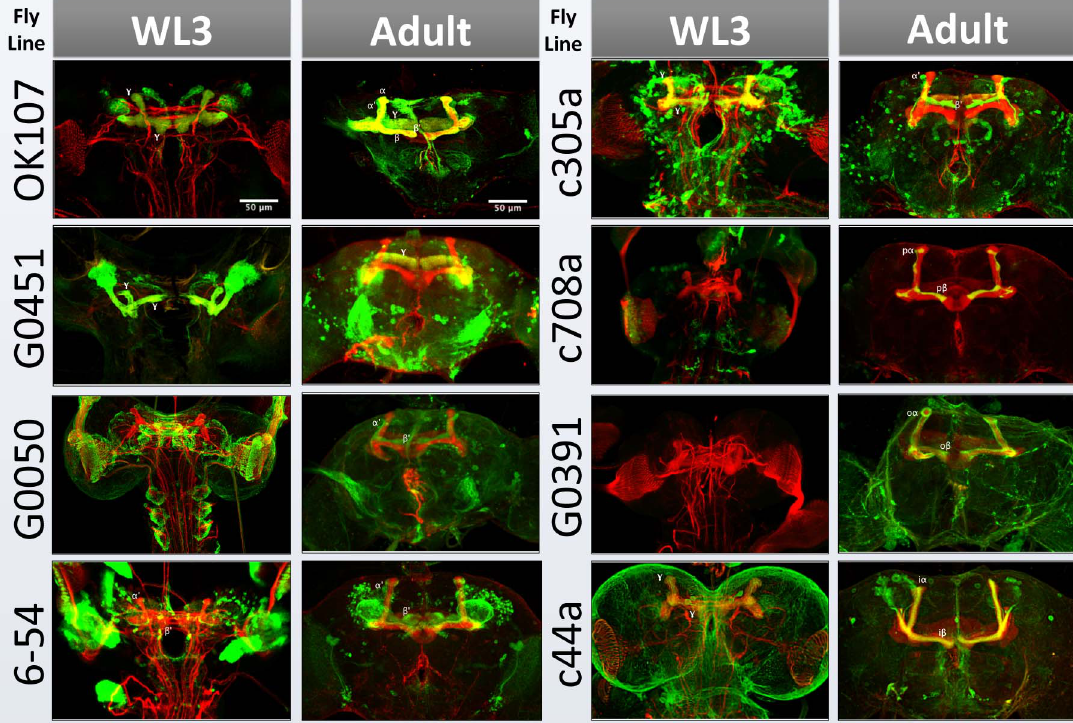
Fig. 5. Expression patterns of GAL4 enhancer trap lines in the fly brain. Each GAL4 strain was used to drive a UAS-CD8-GFP reporter gene (green) and brains were dissected at the wandering third instar larval stage (WL3) and adult. All samples were counterstained with an antibody to FasII (red) to label the developing axon scaffold and specific mushroom body lobes: c in larva, c (low) and a / b (high) in adult. OK107-GAL4 is expressed in the entire mushroom body throughout development. Reporter gene expression in larval c neurons is indicated where present. In adult brain, G0451 labels c ; G0050 , 6-54 , and c305a label a 9 / b 9 ; c708a labels p a / b (pioneer a / b ); G0391 labels o a / b (outer/earlier born a / b ); and c44a labels i a / b (inner/later born a / b ) neurons.